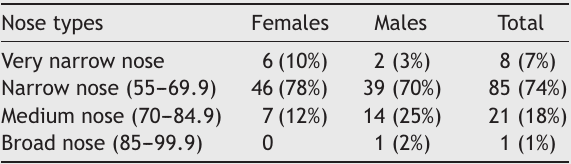
nasofrontal suture. Subnasale (sn), the midpoint of the col- umella base. Pronasale (prn), the most prominent point on the nasal tip. Glabella (g), the mid-point between the eye- brows. Labiale superius, the midpoint of the upper vermilion line, and the alare (al), the point where the nasal blade (ala nasi) extends farthest, 12 are shown in Fig. 1A and B.